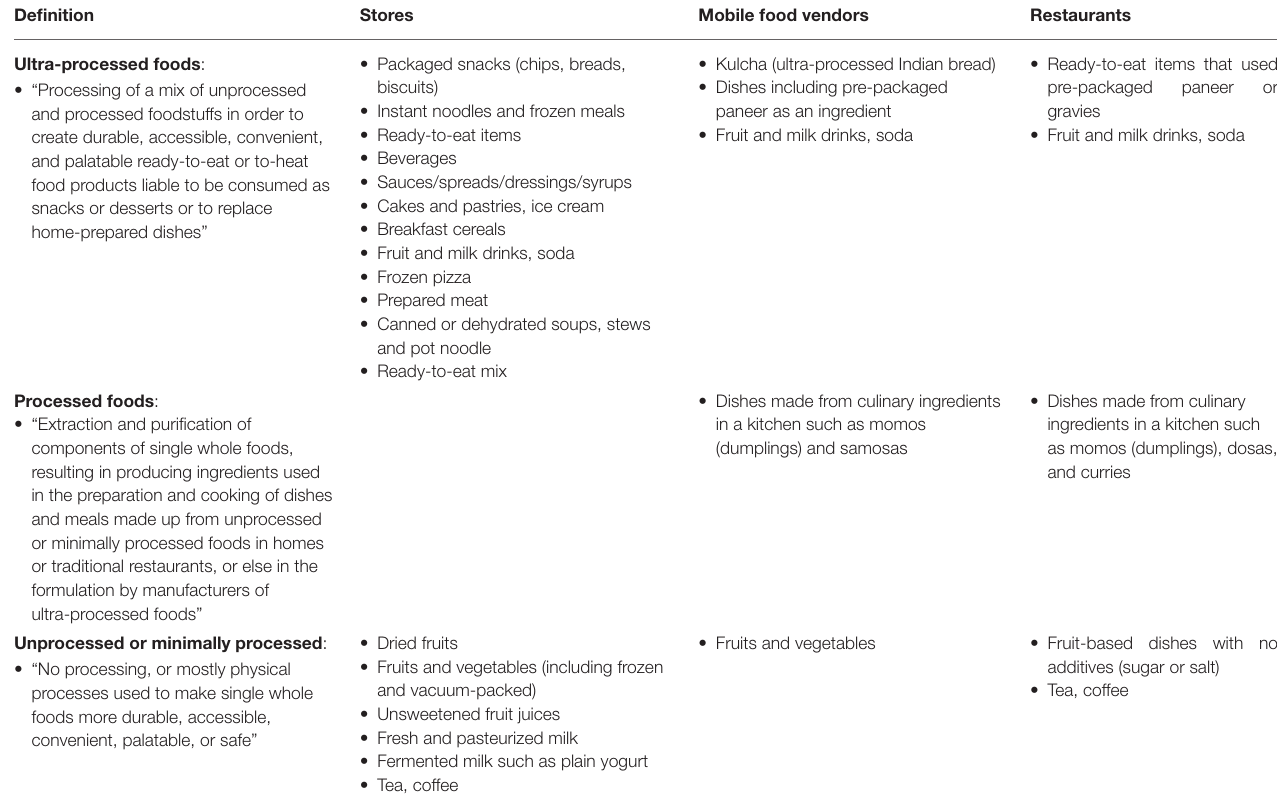
TABLE 3 | Categorization of foods according to level of processing (adapted from Monteiro et al., 2018). Definition